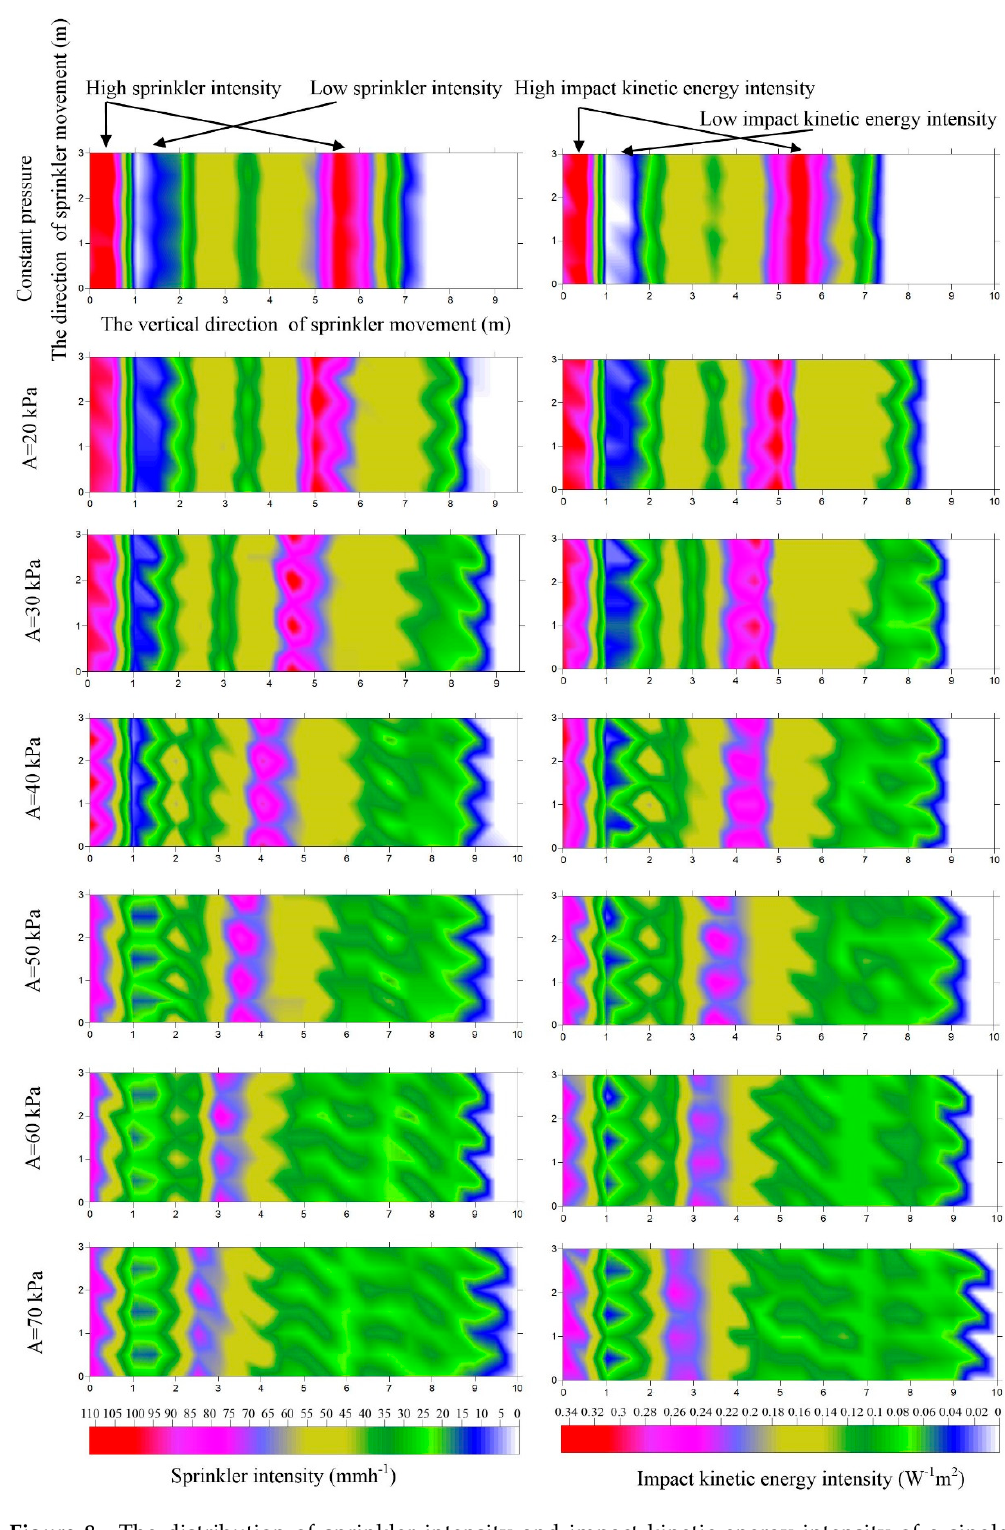
Figure 8. The distribution of sprinkler intensity and impact kinetic energy intensity of a single moving sprinkler.